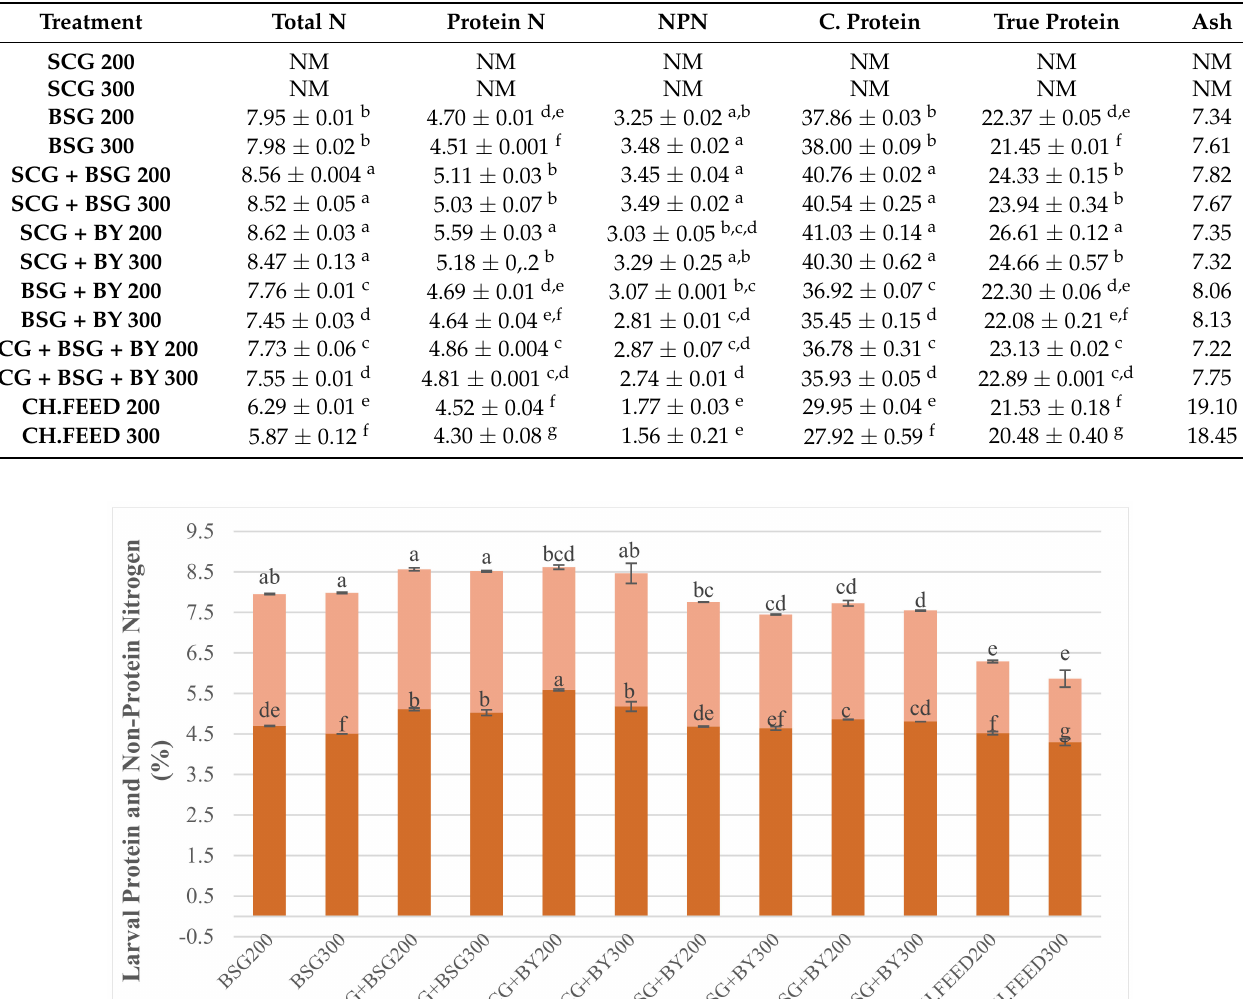
Table 5. Nutrient composition of the BSF larvae fed on SCG, BSG, BY and their mixtures (mean ± standard error n = 3). Mean values followed by different letter in the same column vary significantly ( p < 0.05). NM: Not measured.